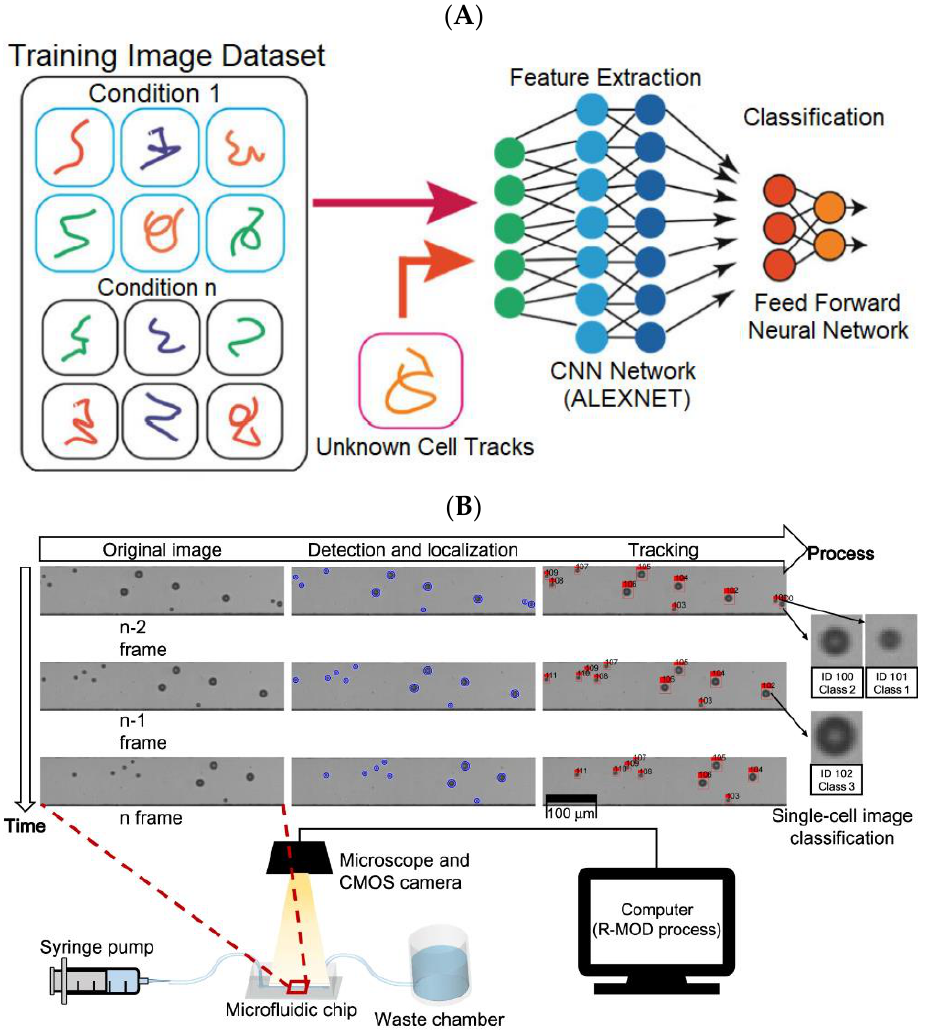
Figure 4. Application of deep learning in classification. A and B are directly cropped from the corresponding papers [54,58], respectively. ( A ) The work [54] utilized AlexNET to classify the cell motility behaviors by implementing transfer learning on the input cell trajectories. Reproduced with permission from Springer Nature Copyright (2023). ( B ) Schematic of the designed system and the real-time moving object detector (R-MOD) in work [58]. Reproduced with permission from Springer Nature Copyright